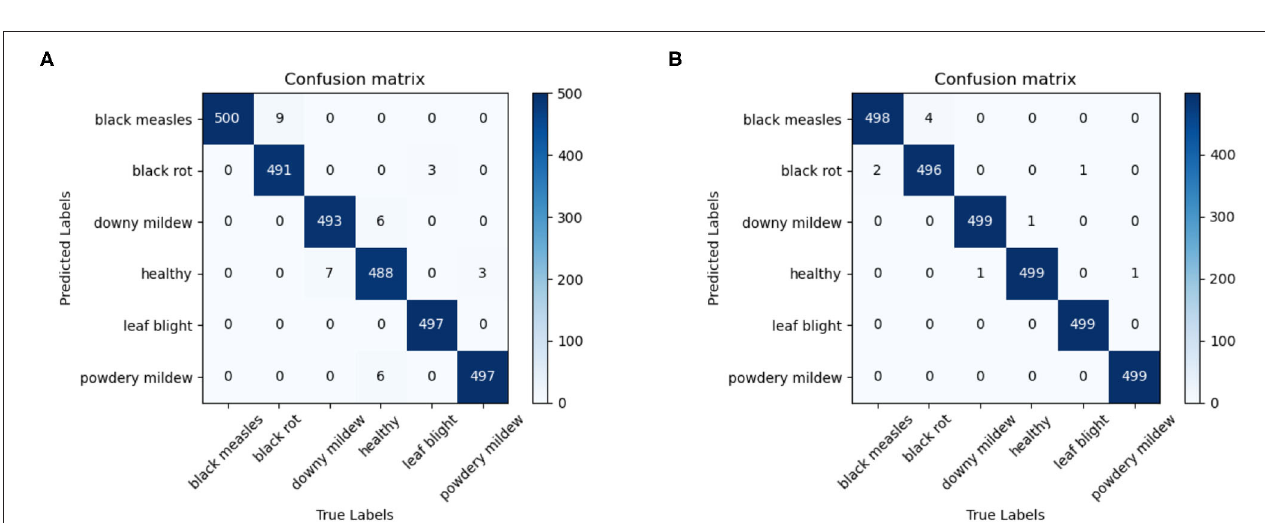
FIGURE 8 | Confusion matrix of proposed ECA-SNet. (A) ECA-SNet_ 0.5 × (B) ECA-SNet_1.0 ×